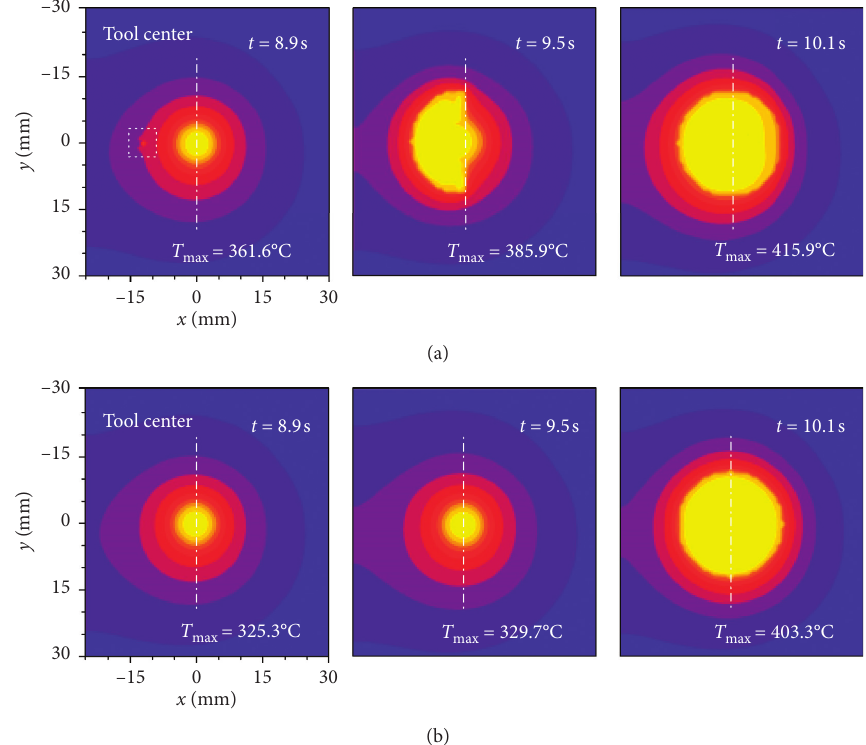
Figure 17: The predicted temperature distributions on the top surfaces in the shoulder-plunging stage in two models. (a) MAM; (b) CAM.